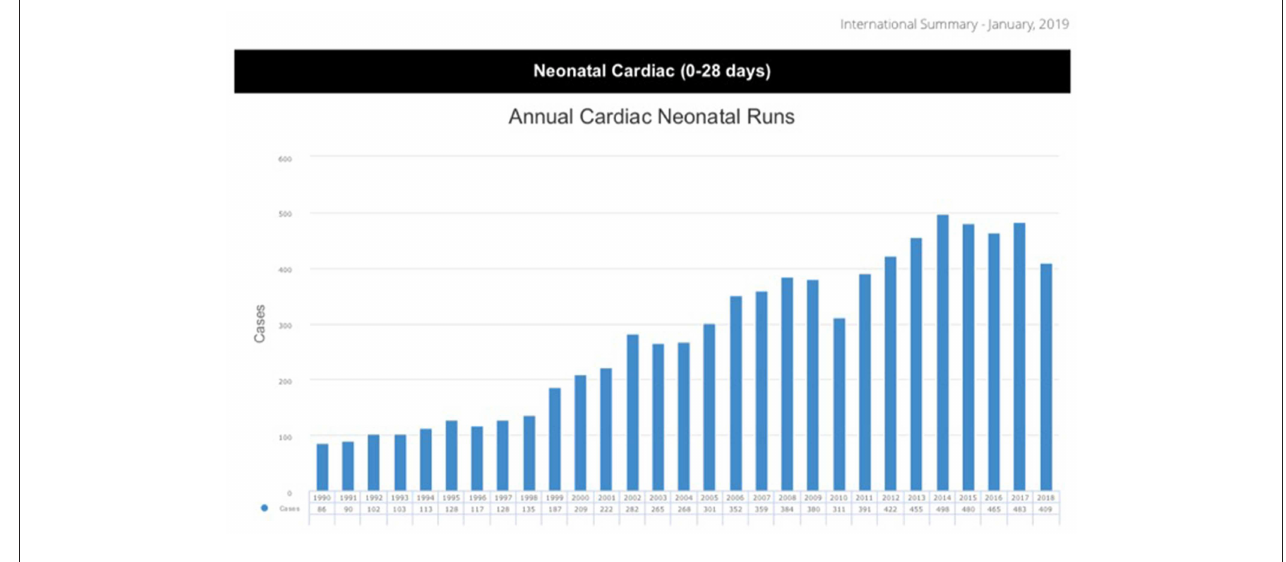
FIGURE 1 | ELSO data report 2019